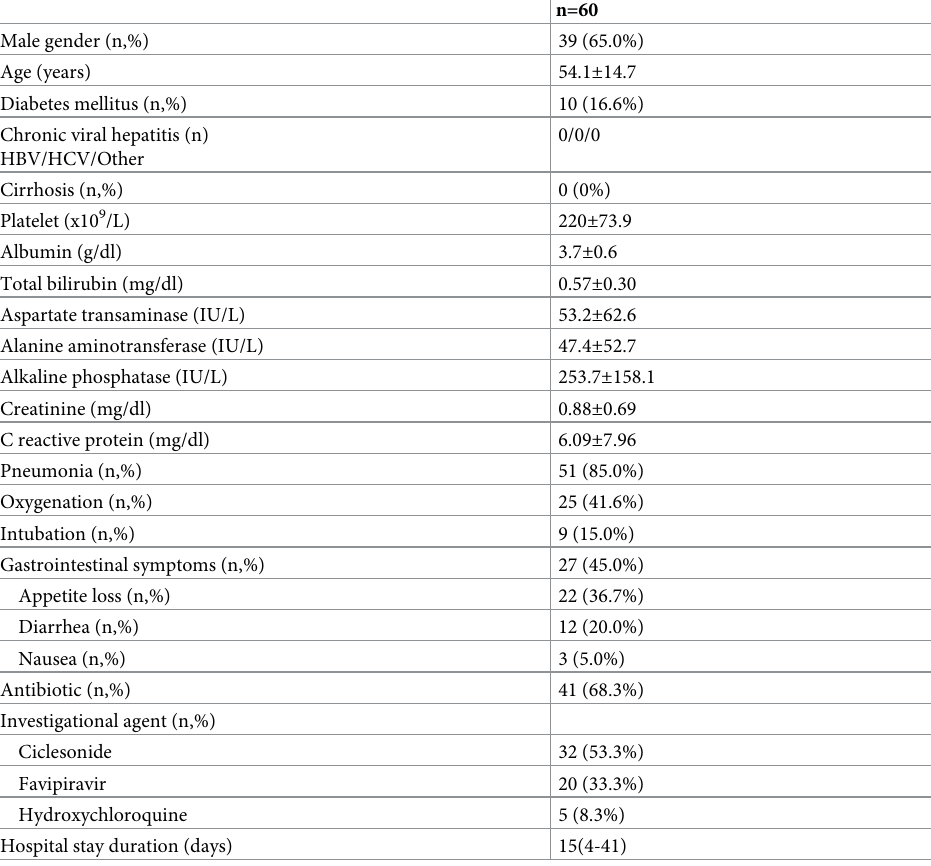
Table 1. Characteristics of patients admitted with COVID-19.